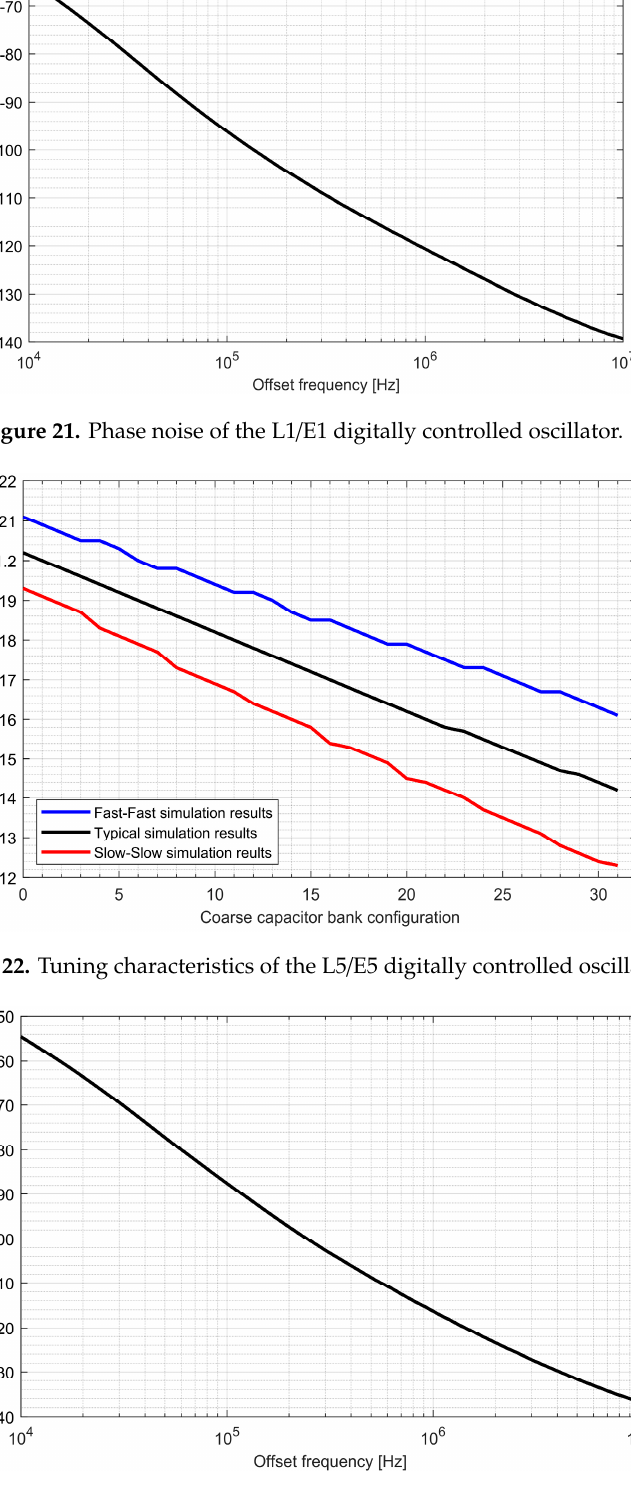
Figure 23. Phase noise of the L5/E5 digitally controlled oscillator.